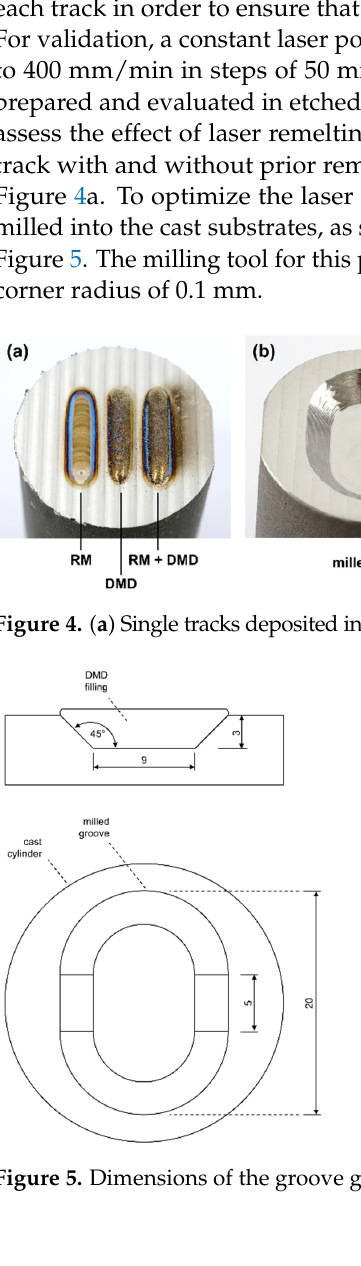
Figure 6. Laser tool path for the DMD groove fillings, with raster tracks in red, linking moves in green, and outer contour tracks in blue. 4. Results and Discussion 4.1. Simulation Results The heat conduction model could be solved with a computation time of less than 30 s, and was therefore selected for analyzing the effects of the processing parameters on the resulting melt pool geometry. In total, 360 process conditions were solved by the heat conduction model within the scope of a full-factorial parameter study (Table 2). The fluid flow model was used to compute the velocity fields within the melt pool and its final dimensions for one reference condition, for which the computation time was over 16 h. The simulative results of both models were then compared to the experimental conditions.